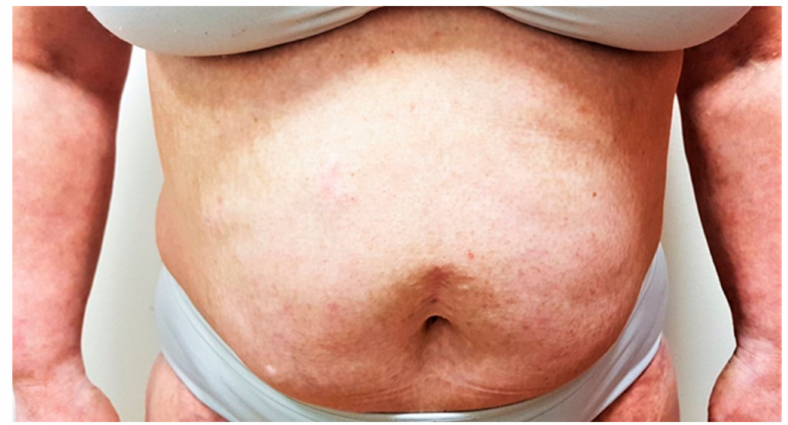
Figure 2. Patient after 2.5 years on dupilumab with EASI score of